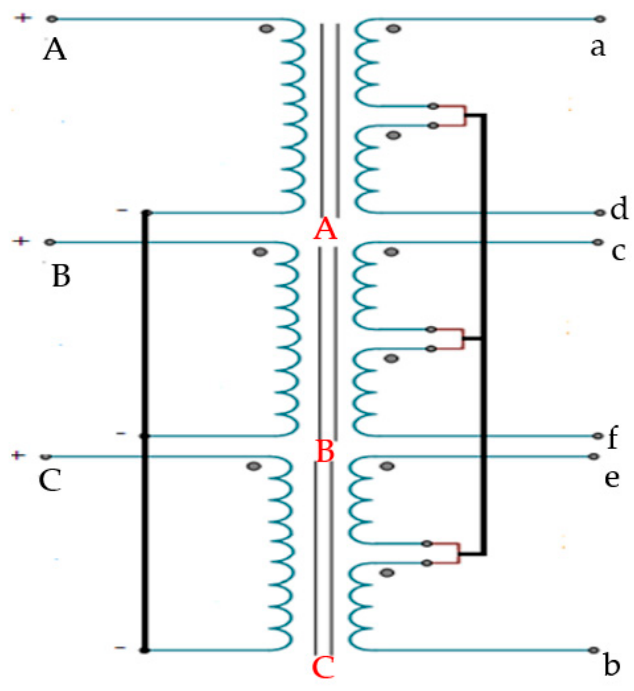
Figure 1. Three-to-six phase transformer connection.